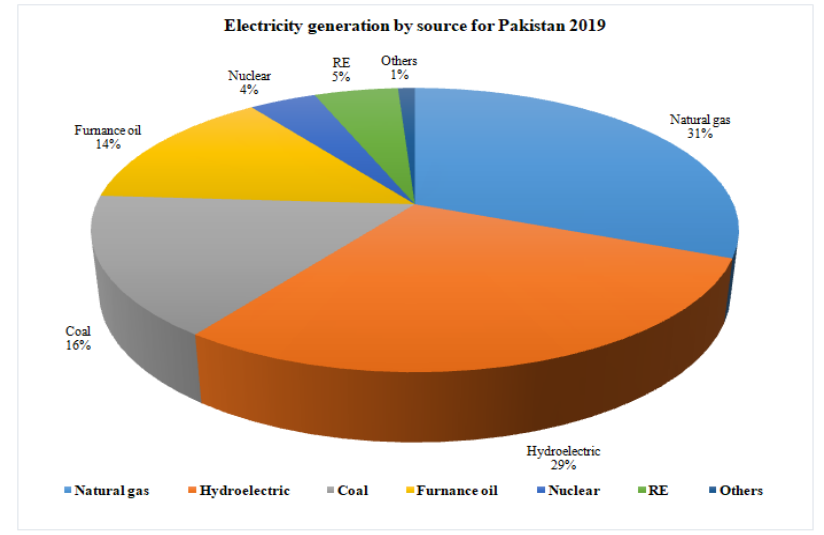
Figure 1. Electricity generation by source for Pakistan 2019 (Source: Ministry of finanace, Pakistan).